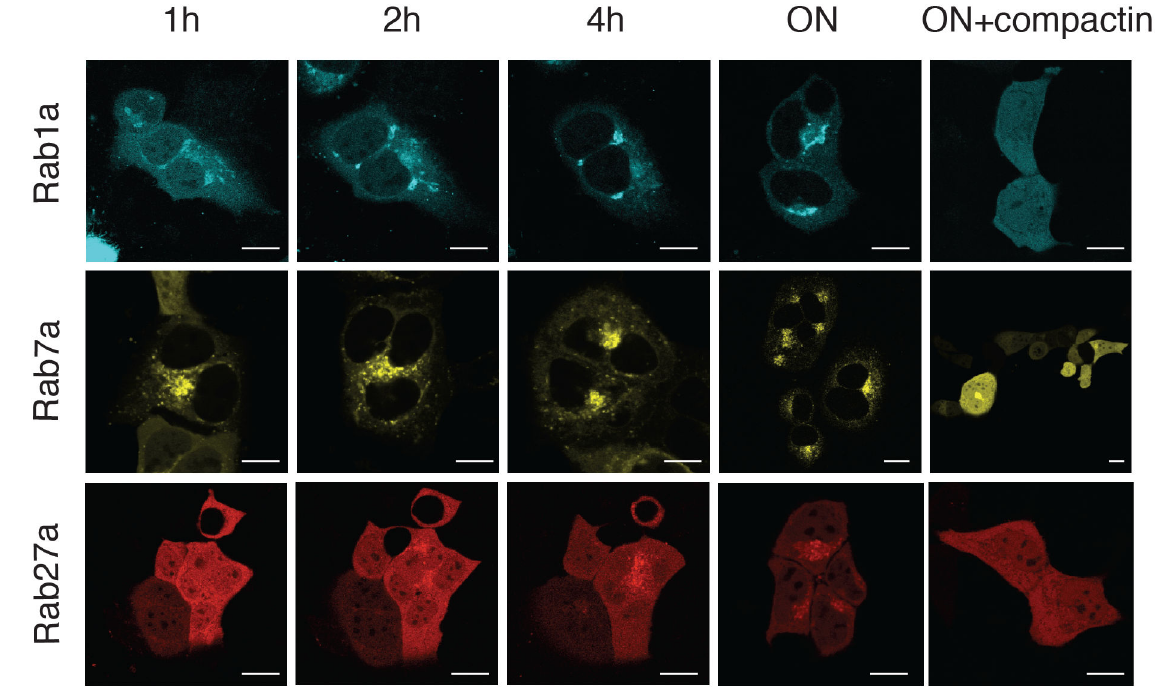
Figure 1. Rates of in vivo prenylation and localization for Rab1a, Rab7a and Rab27a. Unprenylated, fluorescently-tagged recombinant CFP-Rab1a (upper panel), YFP-Rab7a (middle panel) and Cherry-Rab27a (lower panel) were microinjected into A431 cells. Cells were imaged over 22h and cellular localization of the injected Rab proteins detected by their fluorescent tags. The timepoints after microinjection are displayed above the images in hours or overnight (ON). Cells were pre-incubated with compactin where stated. Scale bars represent 20 µm.